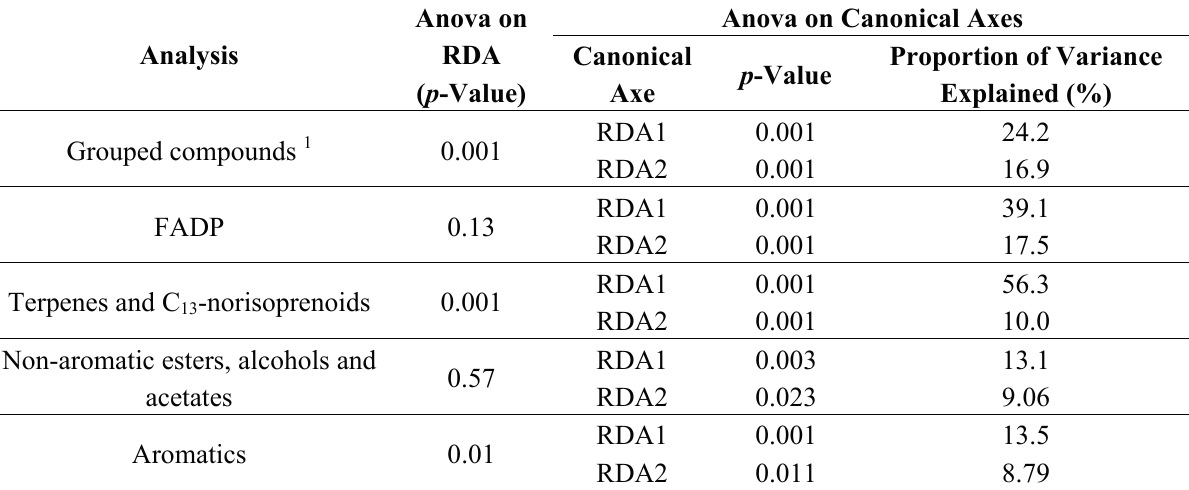
Table 5. Significance of the RDA models and canonical axes assessed by permutation tests (up to 1000 permutations allowed), and proportion of variance explained by each canonical axis (%), for the following RDAs: (1) Grouped compounds; (2) FADP; (3) Terpenes and C 13 -norisoprenoids; (4) Non-aromatic esters, acids and alcohols; (5)